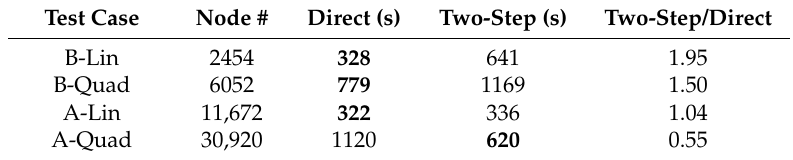
Table 4. Total calculation times for the proposed reduction techniques (Test Cases A and